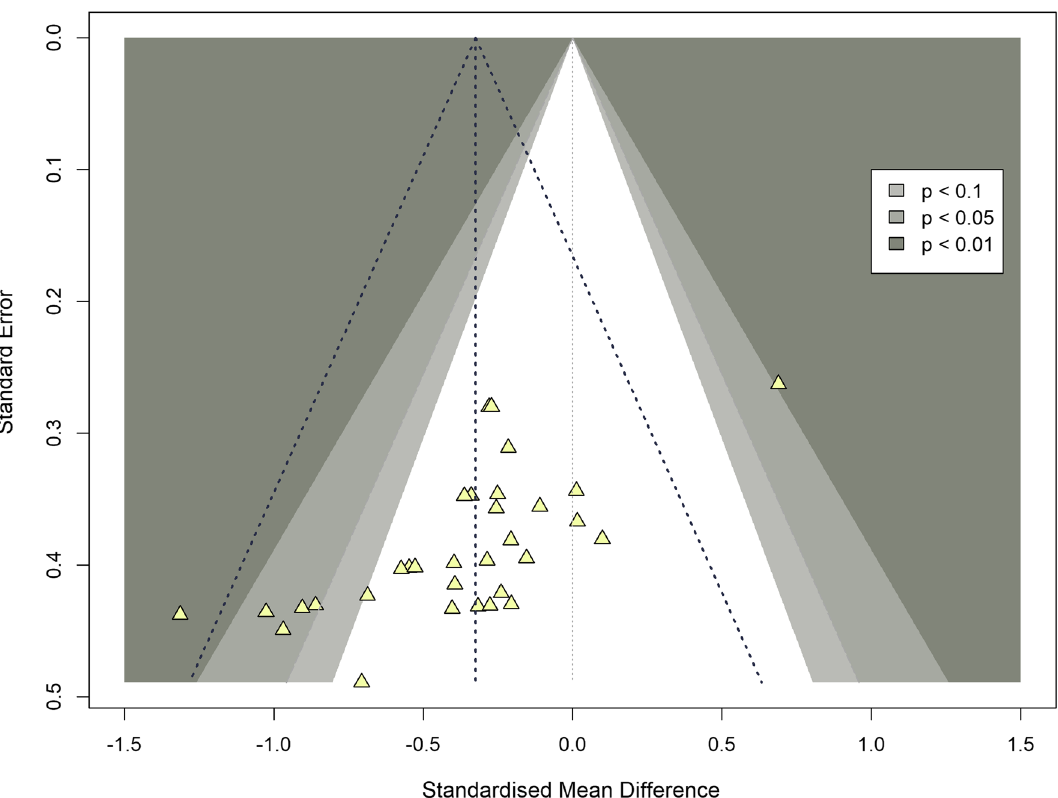
Fig. 6 Funnel plot detailing publication bias of the present review (every study is represented by a yellow triangle; shades of grey detail the significance levels of the included studies; the triangle in the bold dashed line represents the effect of the present